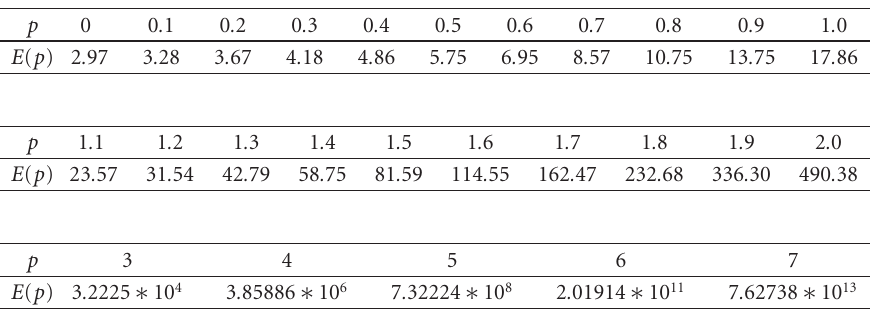
Figure 4.3. x = 0 . 9, p = 0, δ